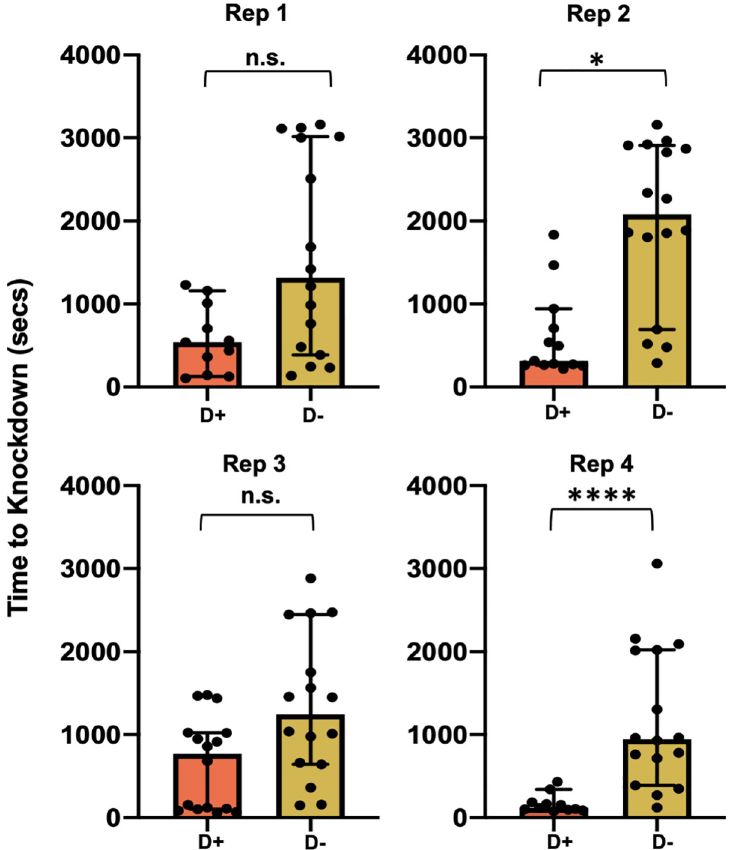
Fig 2. Thermal limits under viral infection. Knockdown time is expressed in seconds for DENV-infected (D+) and DENV-uninfected (D-) mosquitoes with no Wolbachia present in either treatment. Each replicate (4) contained 20 individuals per treatment (40 total per block). Box plots represent individual replicate medians and confidence intervals. Both the factors ‘DENV Infection’ ( p < 0.001) and ‘Replicate’ ( p = 0.035) were significant by ANOVA. p - values report Tukey’s post hoc comparison for each